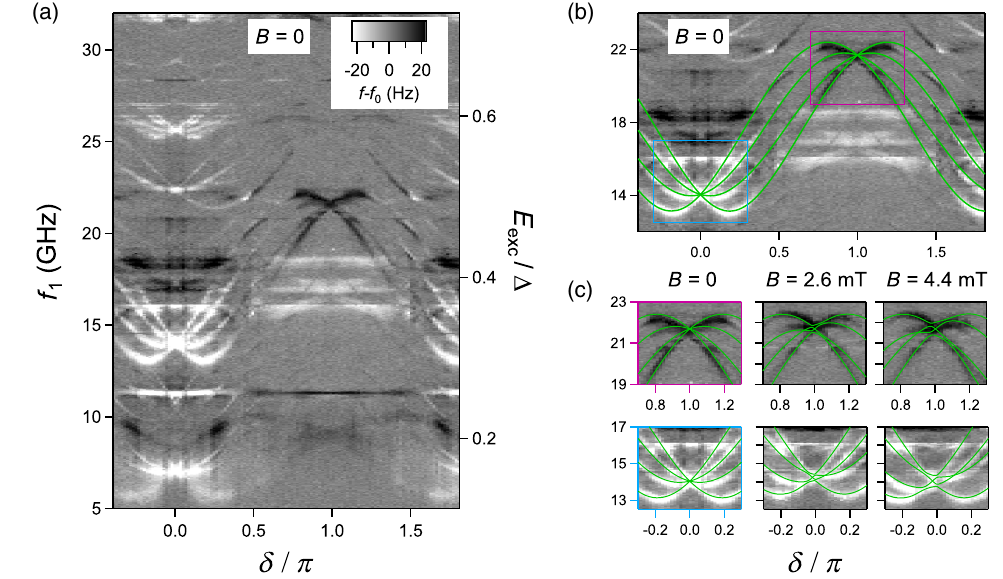
¼ 0 . 5 V. (a) Large-scale spectrum at zero magnetic field. (b) Enlargement of the same data with fits FIG. 5. Excitation spectra at V g (see text). (c) Dependence of the spectrum with the amplitude B of an in-plane magnetic field applied at an angle of − 45 ° with respect to the nanowire axis. Green lines are fits (see